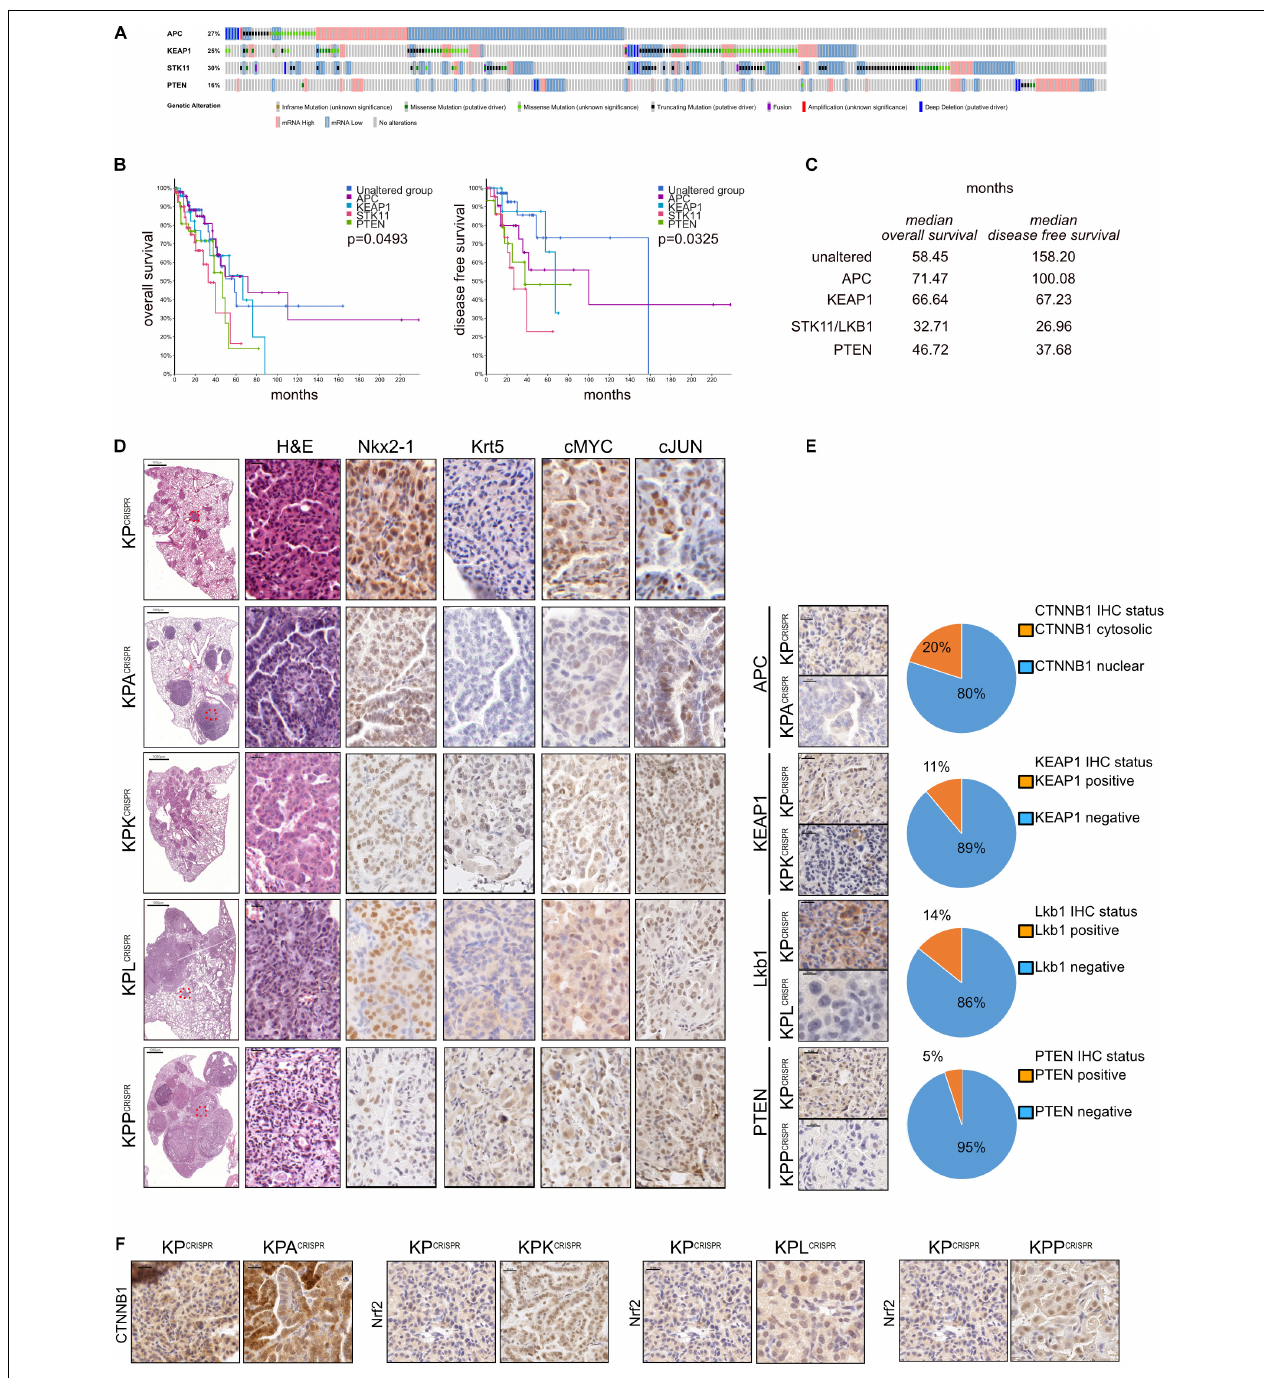
FIGURE 4 | Rapid modeling of common loss-of-function mutations identified in NSCLC patients by CRISPR genome editing. (A) Analysis of occurring alterations in APC, KEAP1, STK11/LKB1, and PTEN in human NSCLC-ADC (www.cbioportal.org). (B) Kaplan–Meier plot of overall and disease-free survival in NSCLC-ADC patients. Shown are the months’ survival. Blue = unaltered group; purple = APC altered; blue = KEAP1 altered; orange = STK11 altered; green = PTEN altered. P < 0.005. (C) Median overall and disease-free survival of patients with the indicated alterations, relative to patients with no mutations in APC, KEAP1, STK11, or PTEN. (D) Representative H&E and immunohistochemical staining against ADC (NKX2-1) and SCC (Krt5) marker expression and the oncogenes cMyc and cJun of mice infected with AAV encoding sgRNA targeting KP, KP-Apc, KP-Keap1, KP-Lkb1, or KP-Pten. Scale bar 20 µ m. (E) Representative immunohistochemical staining against encoding sgRNA targets Apc, Keap1, Lkb1, and Pten in KP, KP-Apc, KP-Keap1, KP-Lkb1, or KP-Pten. Scale bar 20 µ m. Quantification of CTNNB1 nuclear to cytosolic ratio in KP versus KPA tumors. Quantification of Keap1-positive to negative tumors in mice infected with AAV encoding sgRNA targeting Keap1. Quantification of Lkb1/Stk11-positive to negative tumors in mice infected with AAV encoding sgRNA targeting Lkb1/Stk11. Quantification of Pten-positive to negative tumors in mice infected with AAV encoding sgRNA targeting Pten. (F) Representative immunohistochemical staining against Ctnnb1 in KP CRISPR and KPA CRISPR , Nrf2 in KP CRISPR and KPK CRISPR , Nrf2 in KP CRISPR and KPL CRISPR , and Nrf2 in KP CRISPR and KPP CRISPR . Please also see Supplementary Figure 4 .